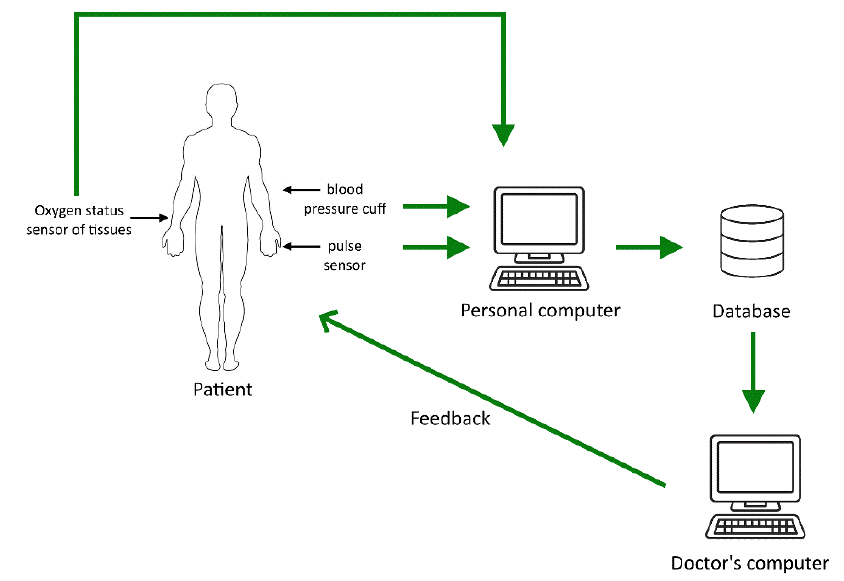
Figure 1. The scheme for monitoring the state of human health in express mode.